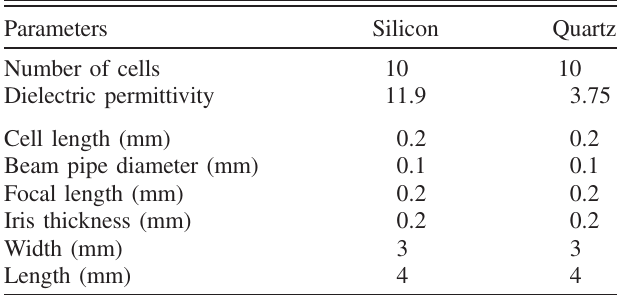
TABLE I. Parameters of THz accelerating structures.